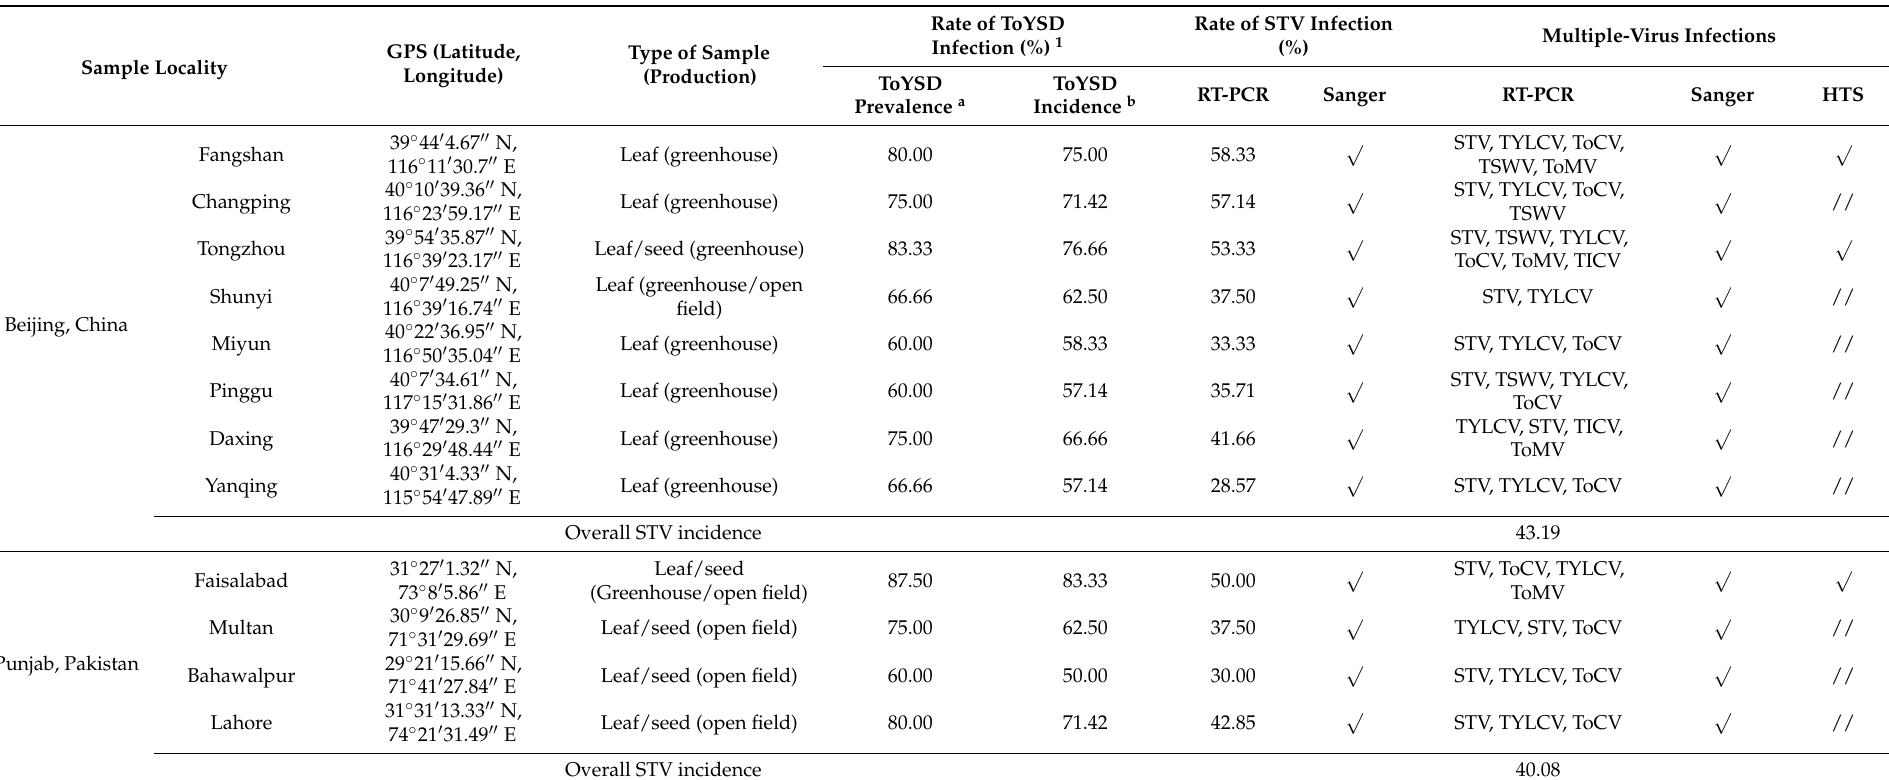
Table 1. STV infection dynamics under field conditions and confirmation through laboratory analysis and high-throughput sequencing technology (HTS).